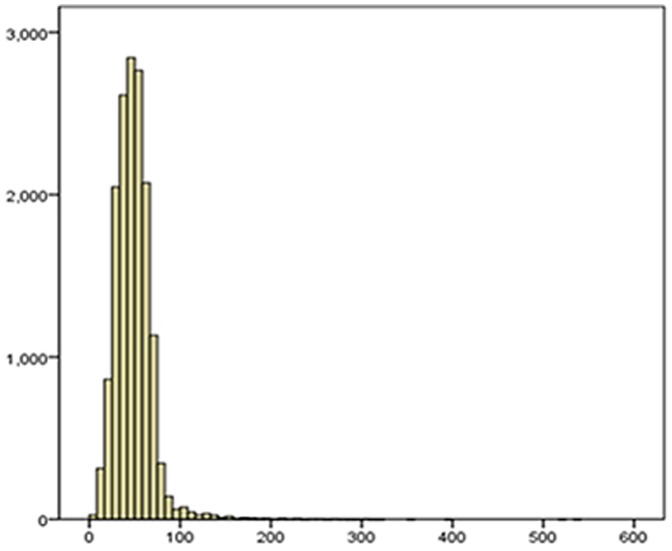
Distribution of blood lead levels among the out-patients in Wuhan.The horizontal axis represents the BLL values, and the vertical axis represents its frequency. Most of Children had BLLs below 100 µg/L, and only 310 children had BLLs higher than 100 µg/L.